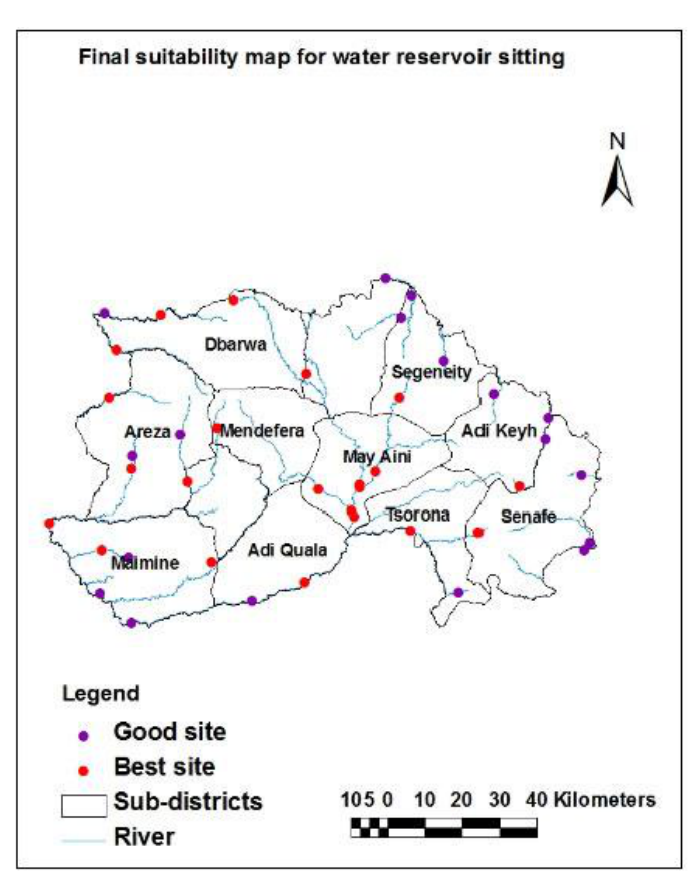
Figure 10. Final suitability map.